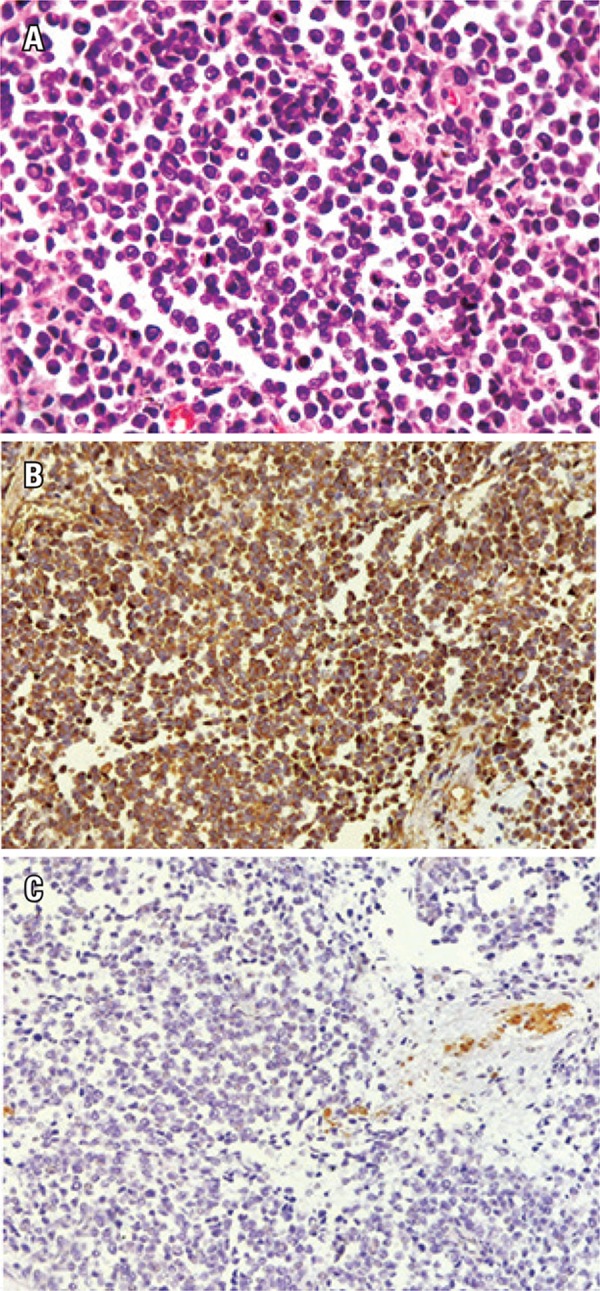
(A) Sarcoma uretral de alto grau; (B) Imuno-histoquímica que revelou forte positividade de vimentina; (C) O tumor uretral também apresentava positividade para desmina